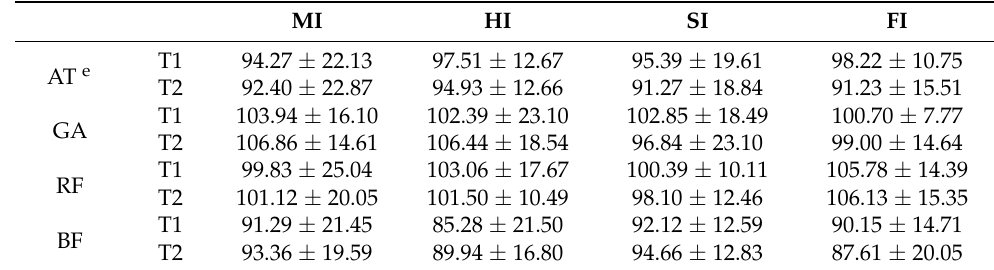
Table 6. Median frequency of EMG